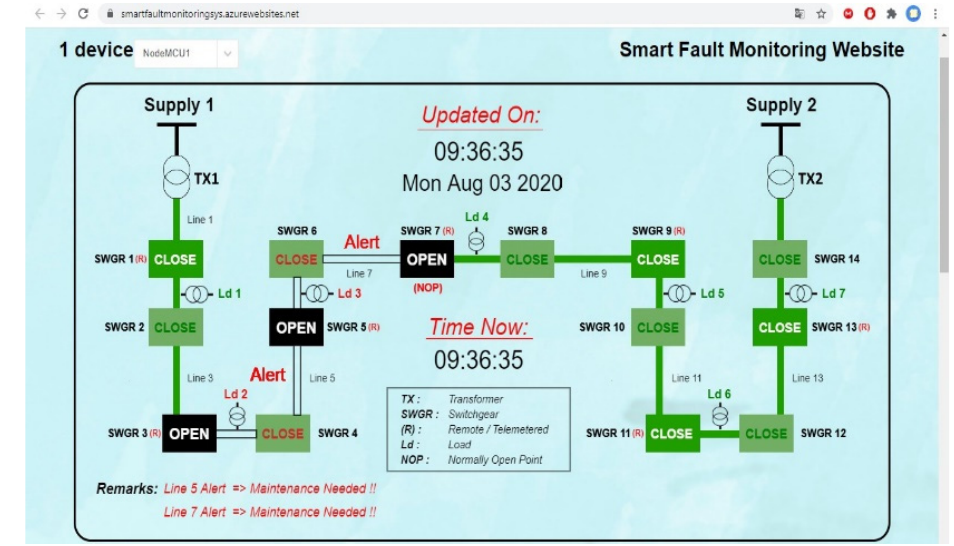
Figure 22. Monitoring website after restoration for Load 1.